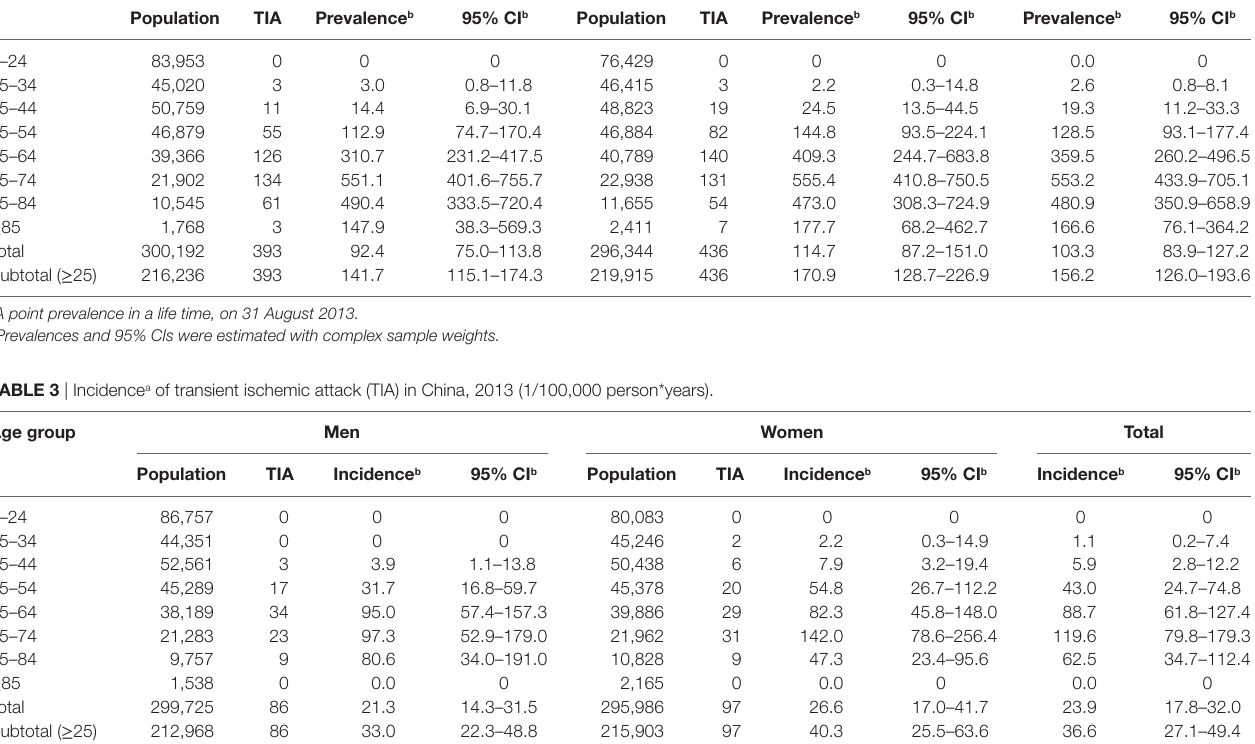
Table 2 | Prevalence a of transient ischemic attack (TIA) in China, 2013 (1/100,000 person*life time). age group Men